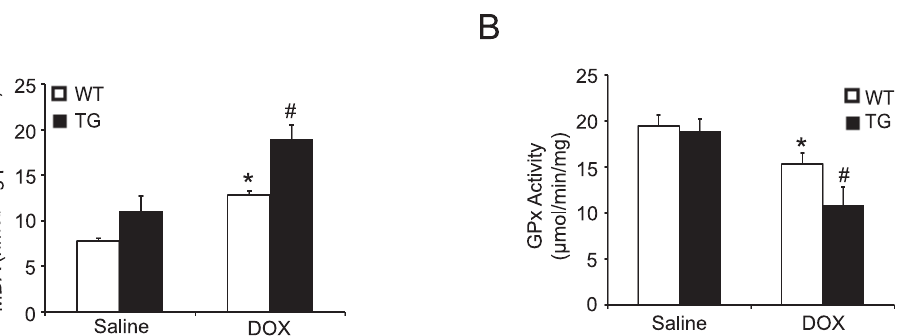
Figure 5. Nrdp1 overexpression increases DOX-induced oxidative stress. Malondialdehyde (MDA) level (A) and glutathione peroxidase (GPX) activity (B) were measured to estimate extent of lipid peroxidation and antioxidation in heart homogenates from WT and Nrdp1 TG mice (n=5 per